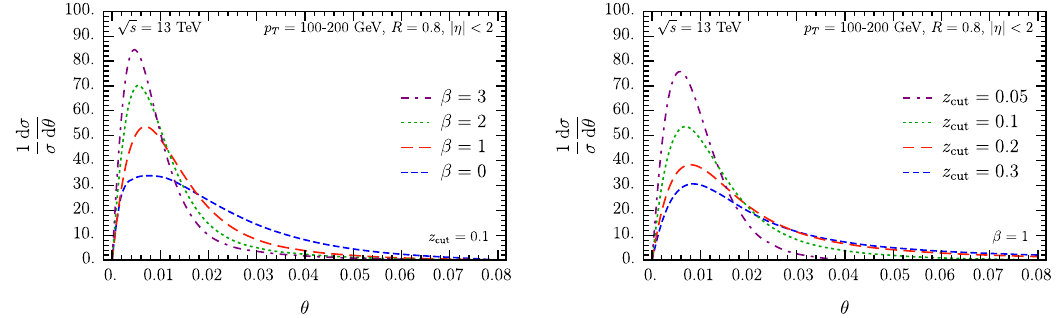
Figure 13 . The angle between the standard and soft drop groomed jet axis for the same kinematics as in the upper right panel of (cid:12)gure 12 but for di(cid:11)erent values of (cid:12) = 0{3 (left), and for di(cid:11)erent values of z cut